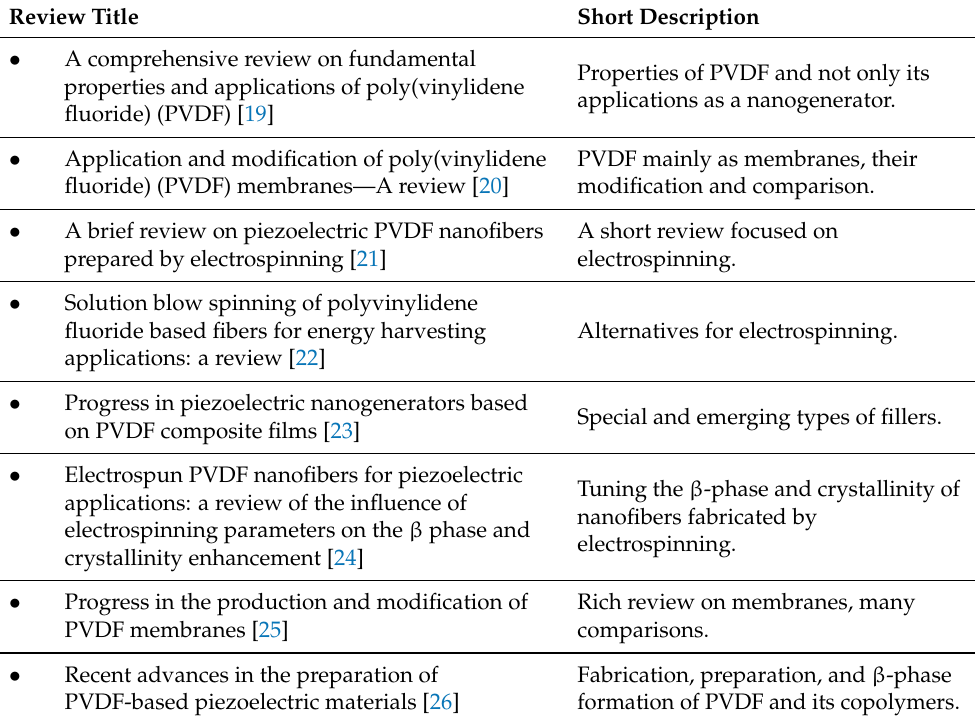
Table 1. Selected publications on a similar topic. The chosen studies are mainly complementary to the current